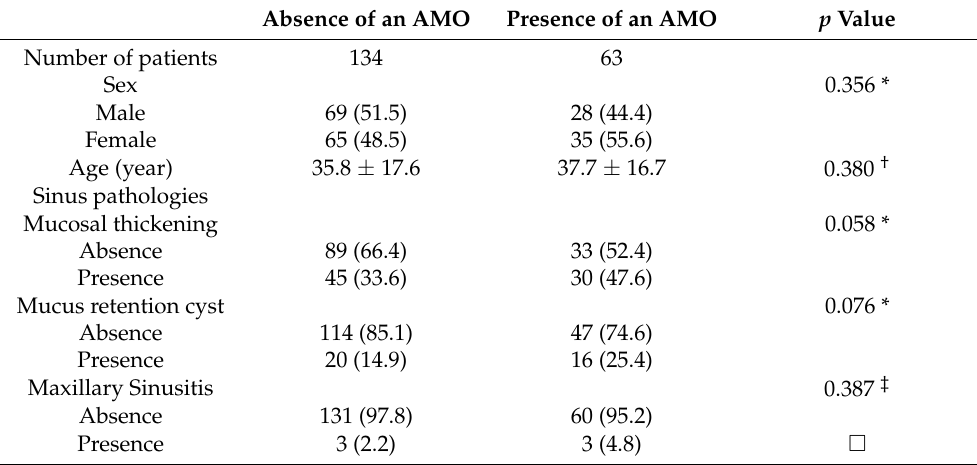
Table 2. Characteristics of patients according to the absence or presence of an accessory maxillary ostium. Absence of an AMO